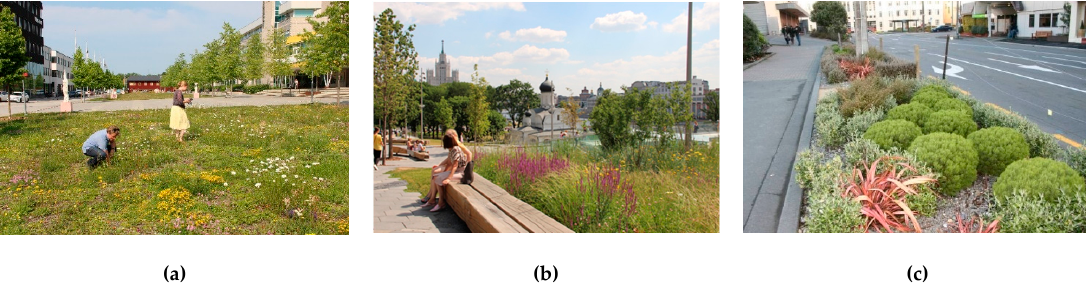
Figure 13. Nature-based solutions for urban lawns: a) Grass-free lawn in the Ultuna campus of Swedish University of Agricultural Sciences in Uppsala (Sweden); ( b ) Steppe Garden in Zaryadye Park in Moscow, Russia; ( c ) native plants for tra ffi c islands in Wellington (New Zealand). Photos: M. Ignatieva, Dushkova.